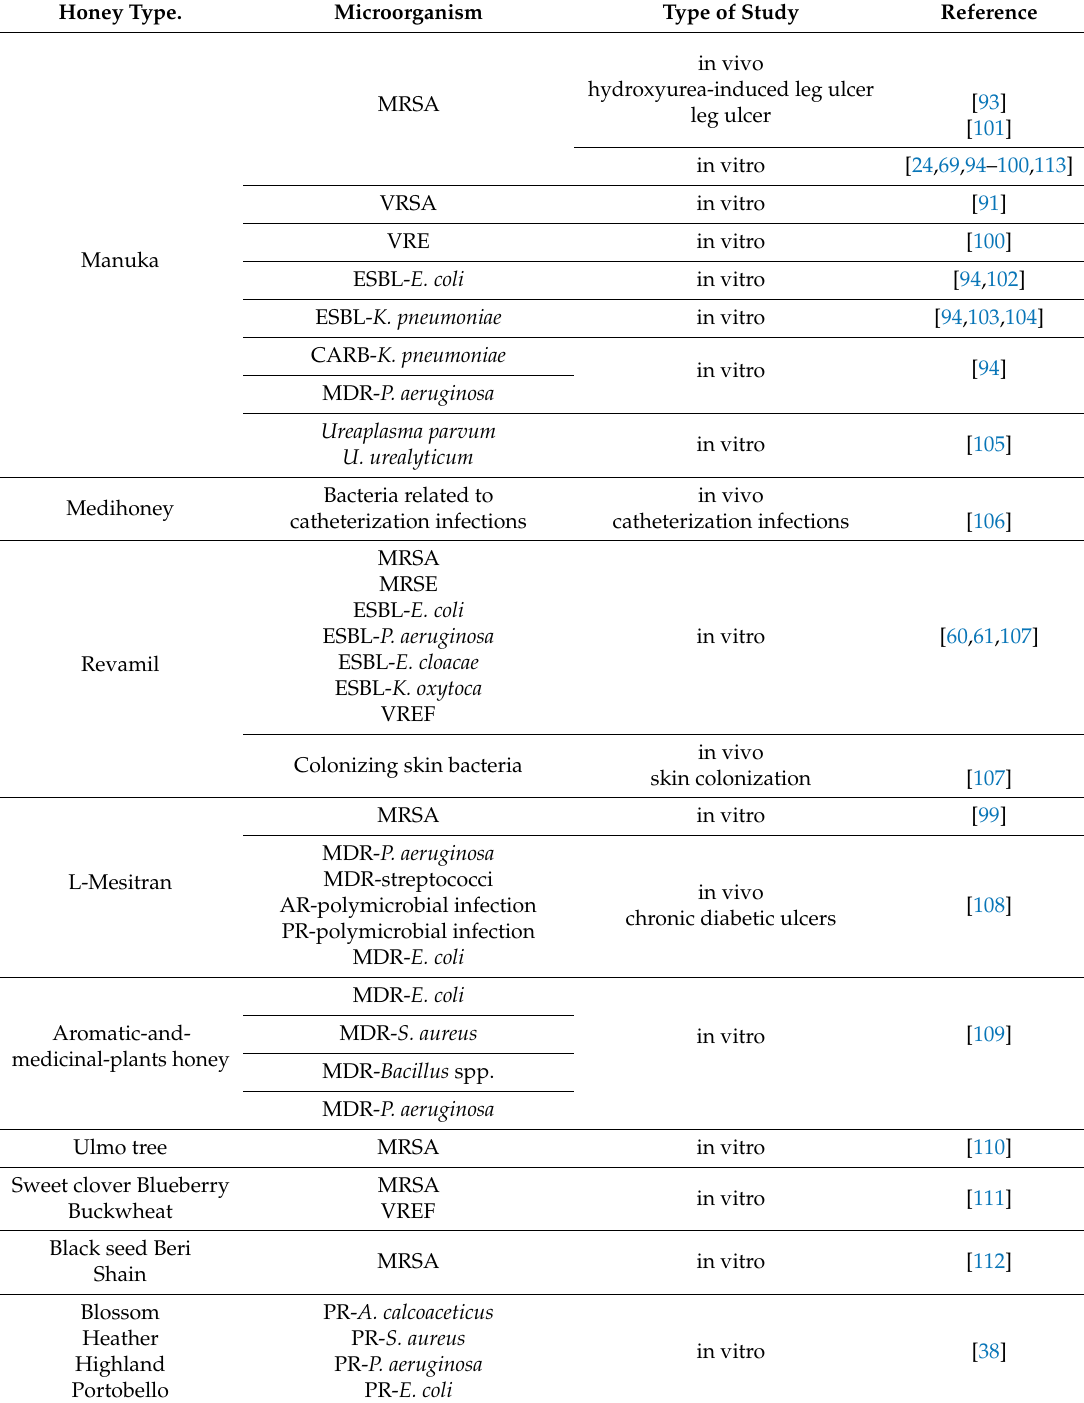
Table 1. Di ff erent honey varieties and honey-based products against antibiotic-resistant bacteria, type of study accomplished (in vitro or in vivo) and reference number of the studies from which the information was